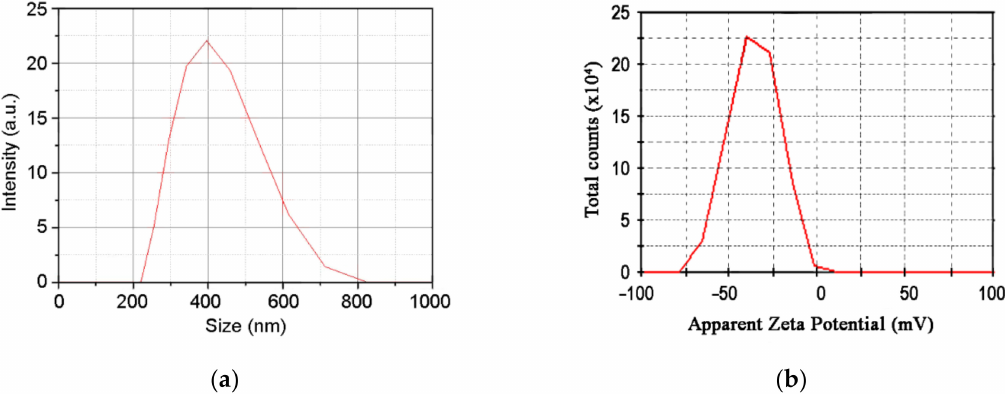
Figure 2. Dynamic light scattering of silica samples: ( a ) hydrodynamic radius; ( b ) zeta